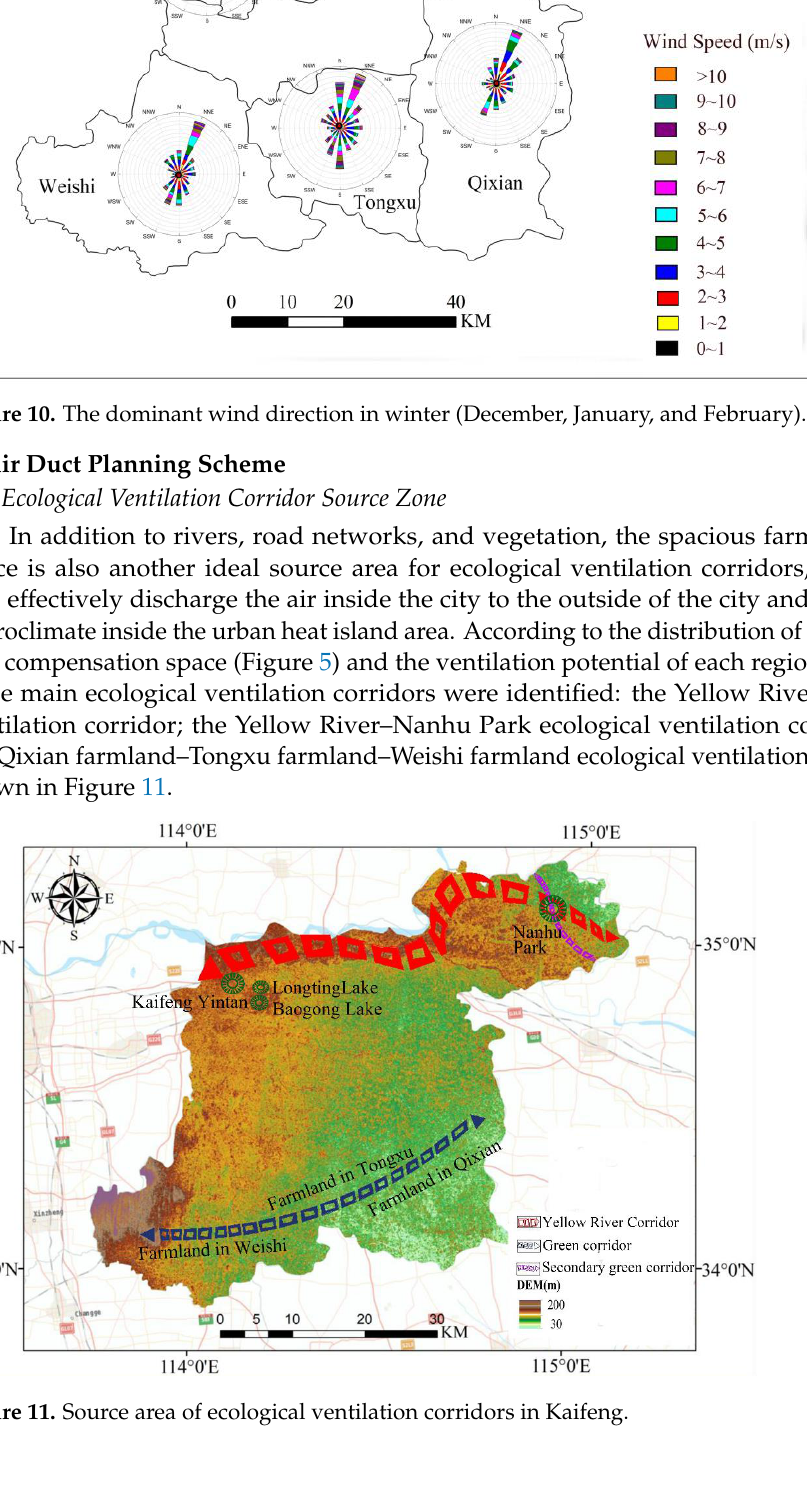
Figure 9 . The dominant wind direction in summer (June, July, and August).